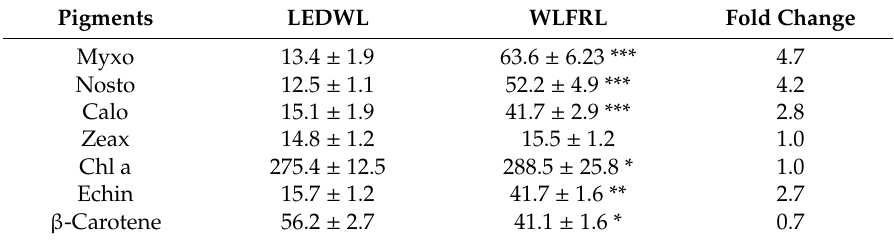
Figure 5. Pigment composition of C. fritschii exposed to ( A ) LEDWL only and ( B ) LEDWL supplemented with FRL (WLFRL). Table 2. Final pigment concentration ( µ g g − 1 of dry weight) of main pigments present in C. fritschii biomass at day 19 of experiment trial for LEDWL and WLFRL conditions, including fold change comparing LEDWL and WLFRL.